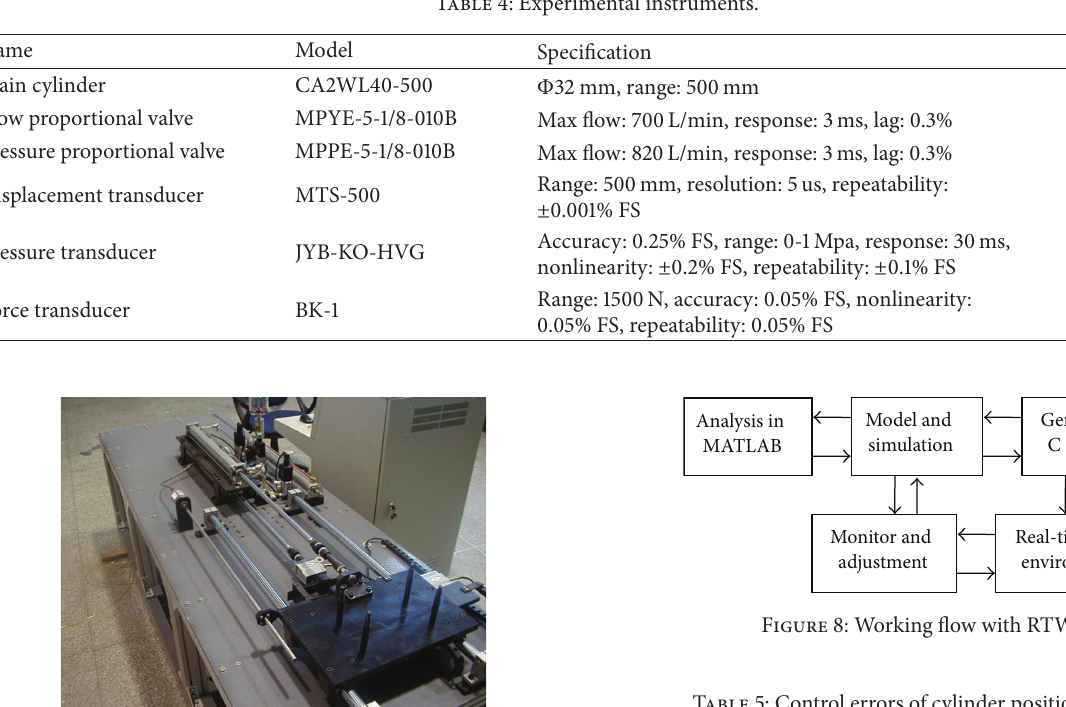
Table 4: Experimental instruments.